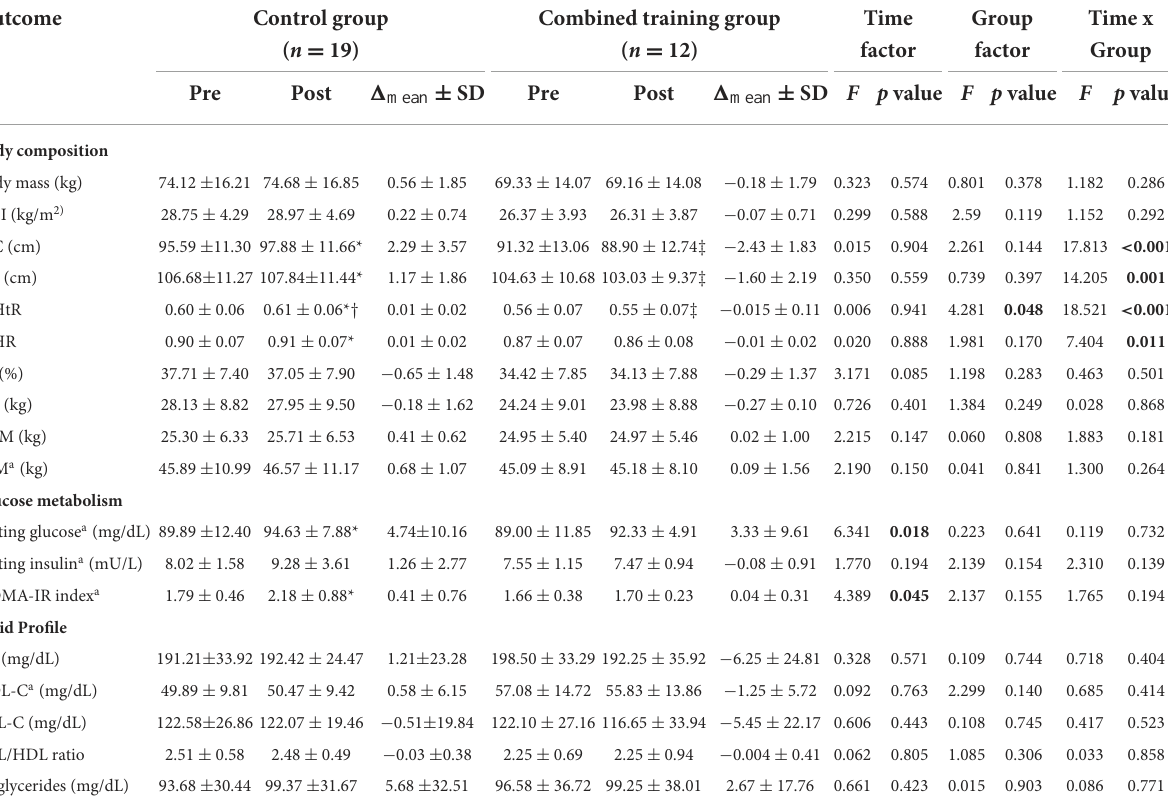
TABLE 2 Differences between baseline and after a 16-week follow-up and between groups on body composition, glucose, and lipid profile outcomes calculated with two-way ANOVA for repeated measures. Outcome Control group Combined training group